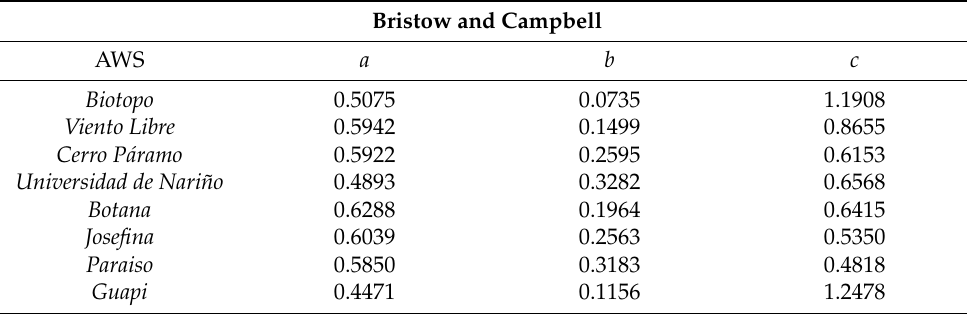
Table 11. Empirical